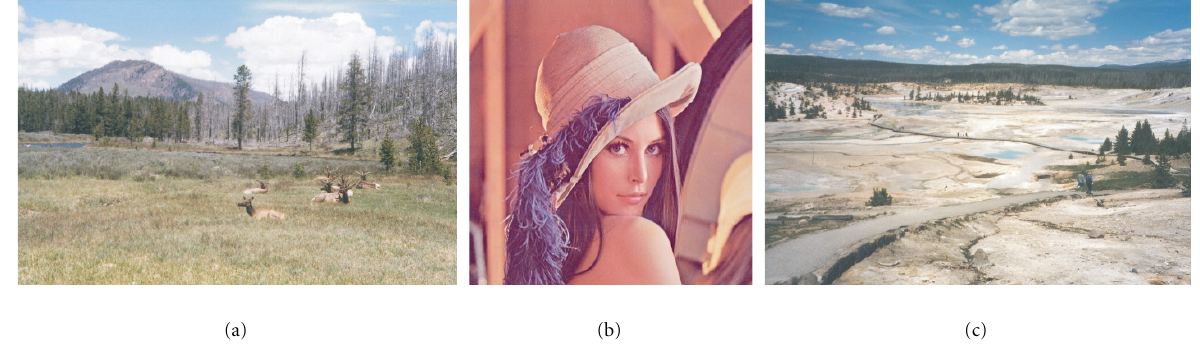
Figure 6: Three color test images P1, P2, and P3.